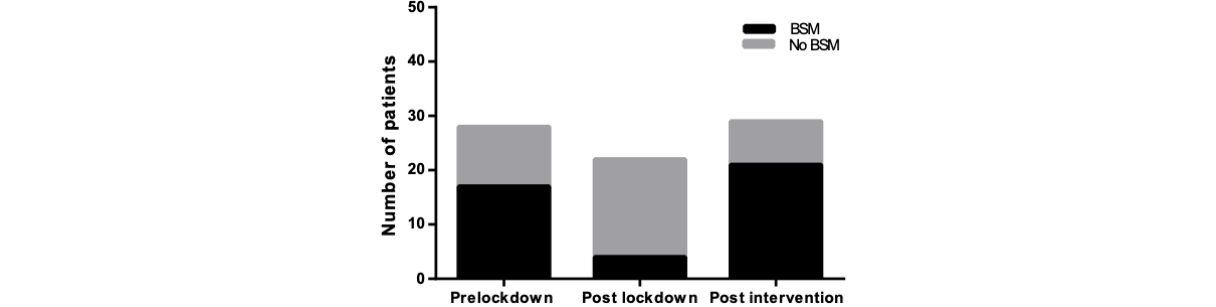
Figure 4. The number of patients receiving correct bone-sparing medication (BSM) after the lockdown was significantly reduced ( P <.001); post intervention, there was a significant increase in the correct administration of BSM ( P <.001), compared to post lockdown.